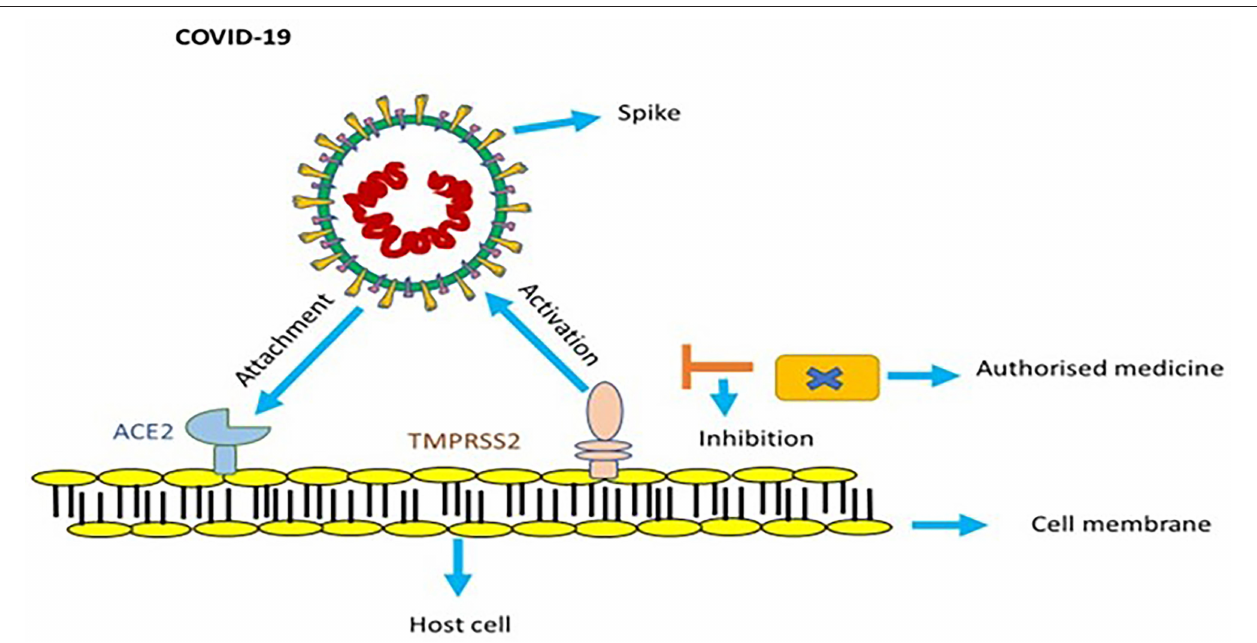
FIGURE 2 | In order to get activated, spike of COVID-19 utilizes ACE2 and TMPRSS2 protease. Endorsed medicines targeted to counter TMPRSS2 prevent infection of COVID-19.